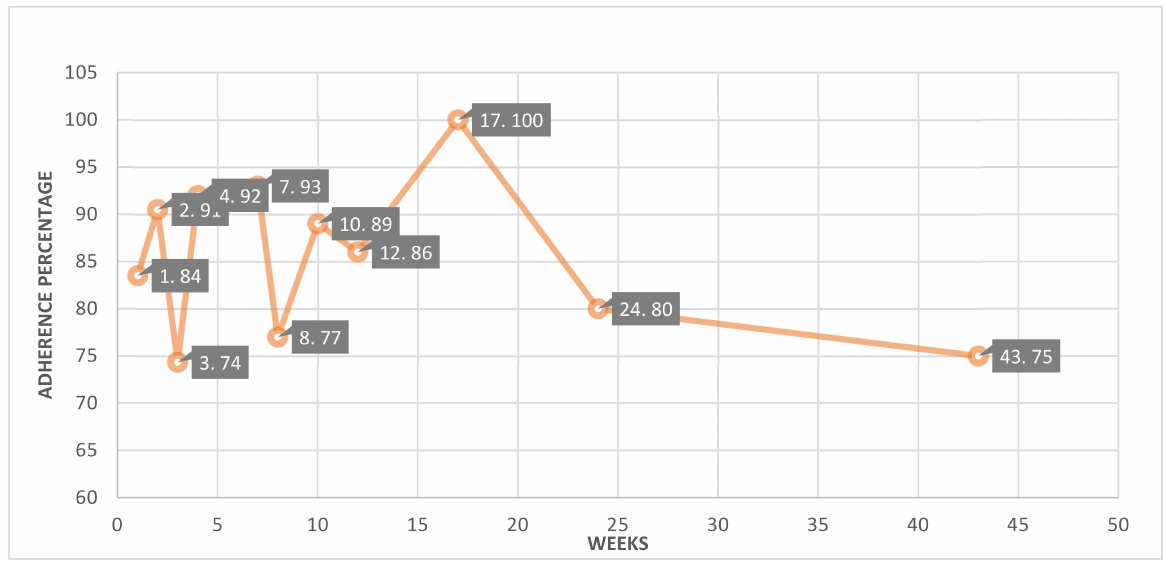
Figure 2. Graphical representation of adherence to wearable devices by duration of